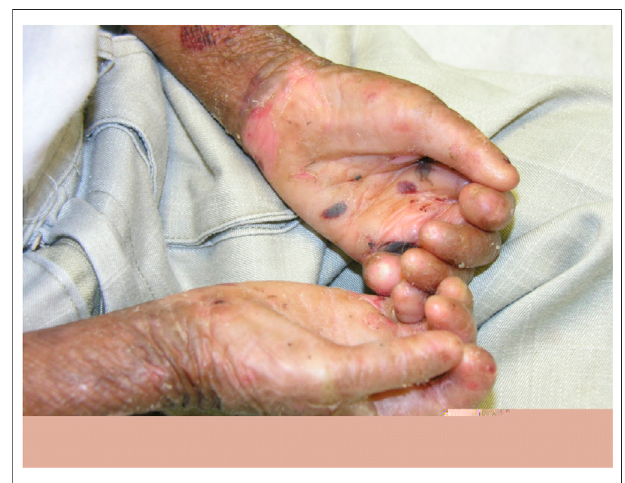
FIGURE 1 | Clinical presentation of dystrophic epidermolysis